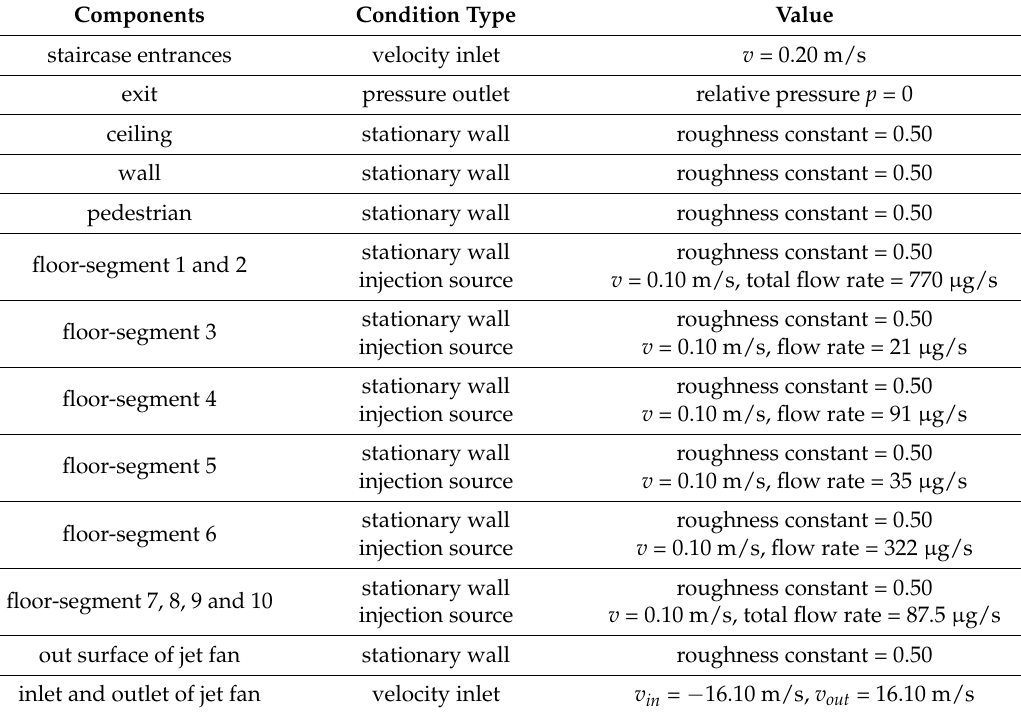
Table 2. Condition types and values of components in the computational